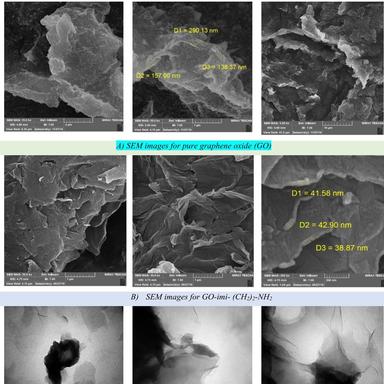
SEM and TEM captured images for pure graphene oxide (GO) and GO-imi- (CH2)2-NH2.